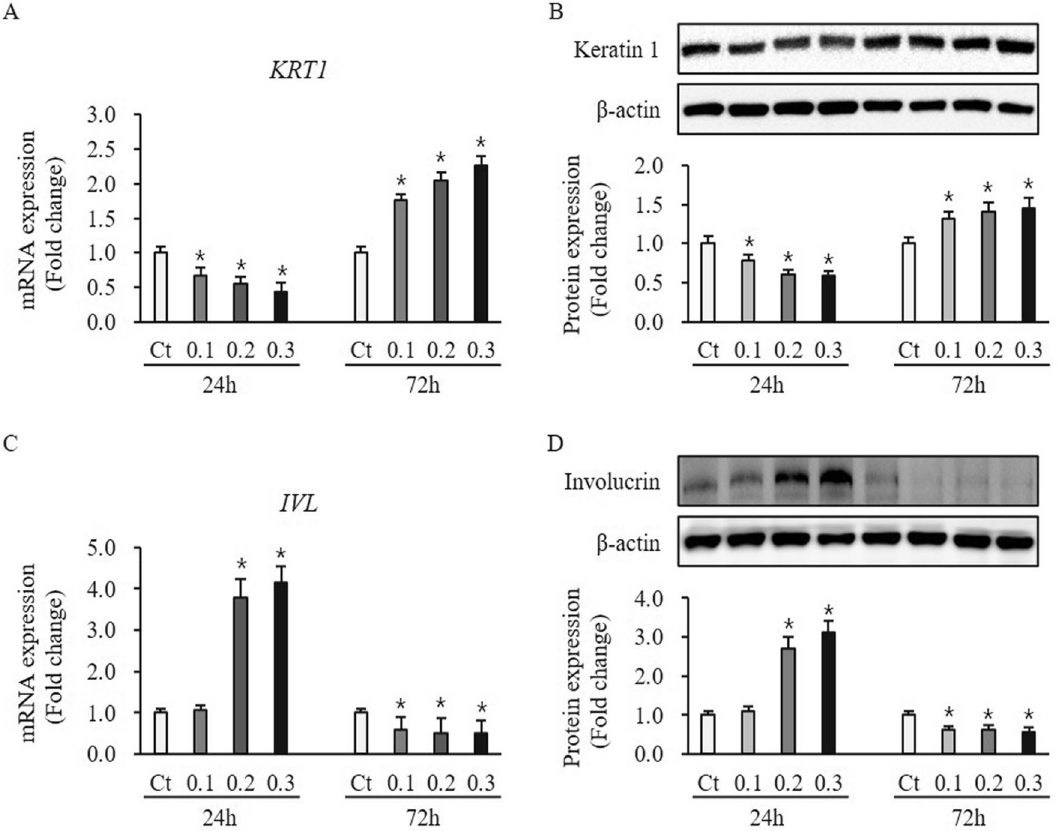
Figure 6. Expression of differentiation marker in HTSKs after ESWT. Significantly decreased and increased mRNA (A) and protein levels (B) of keratin 1 ( KRT1 ) in HTSKs at 24 h or 72 h after ESWT under 0.1, 0.2, and 0.3 mJ/mm 2 of energy flux density, comparted with those in untreated control. Significantly increased and decreased mRNA (C) and protein levels (D) of involucrin ( IVL ) in HTSKs at 24 h or 72 h after ESWT, comparted with those in untreated control. In the fold change, untreated control cells marked as value 1; Ct, untreated control cells; HTSK, hypertrophic scar keratinocyte; * P < 0.05 for ESWT-treated cells vs. the corresponding matched untreated control cells. Data represent means ± SD; n =